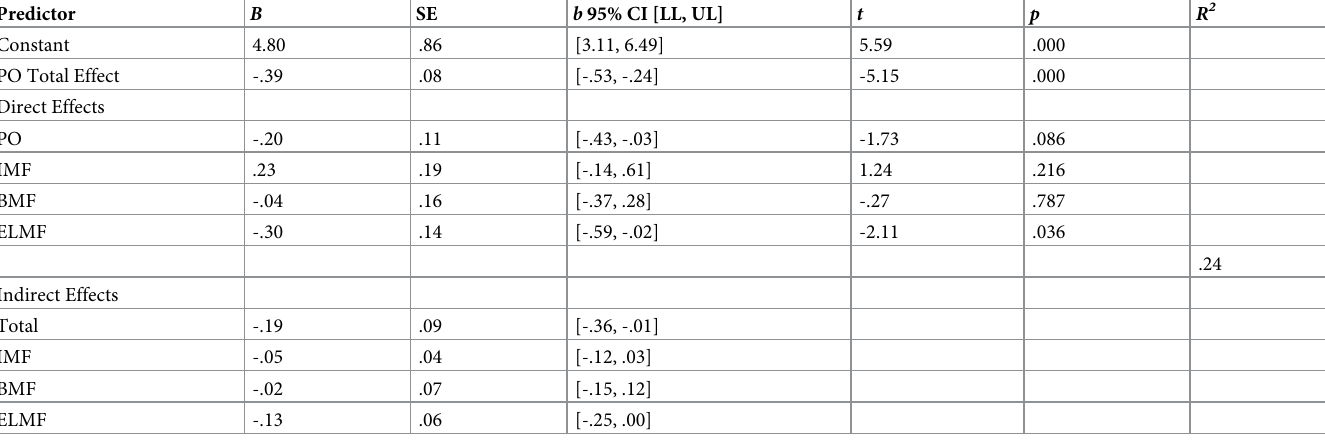
Table 12. Mediation effects of moral foundations on the relationship between political orientation and social distancing compliance scale–future duration of com- pliance (N = 209). Predictor